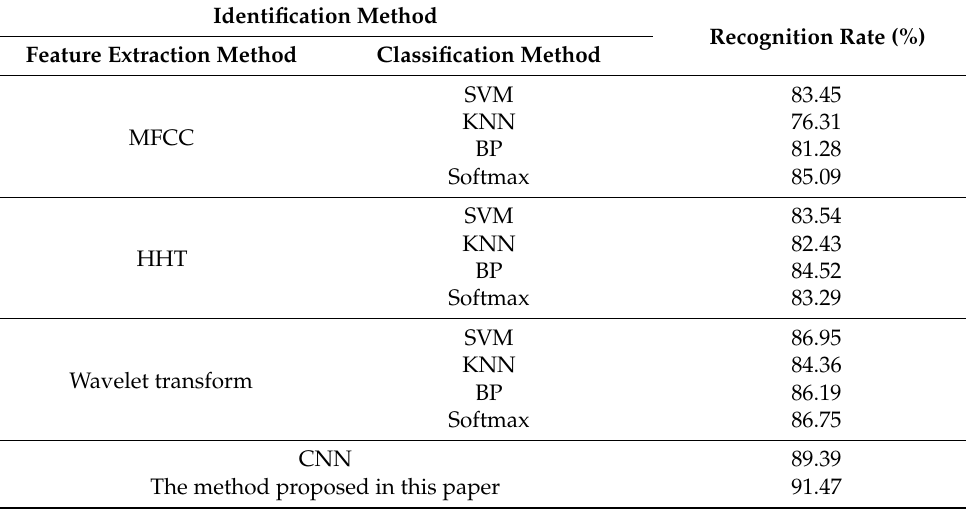
Table 4. Recognition rate of underwater targets by different